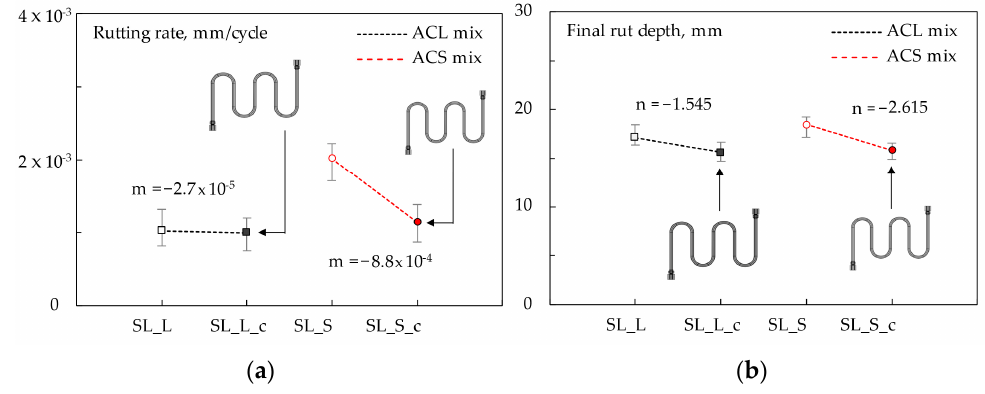
Figure 11. Second-phase rutting rates ( a ) and final rut depths ( b ).